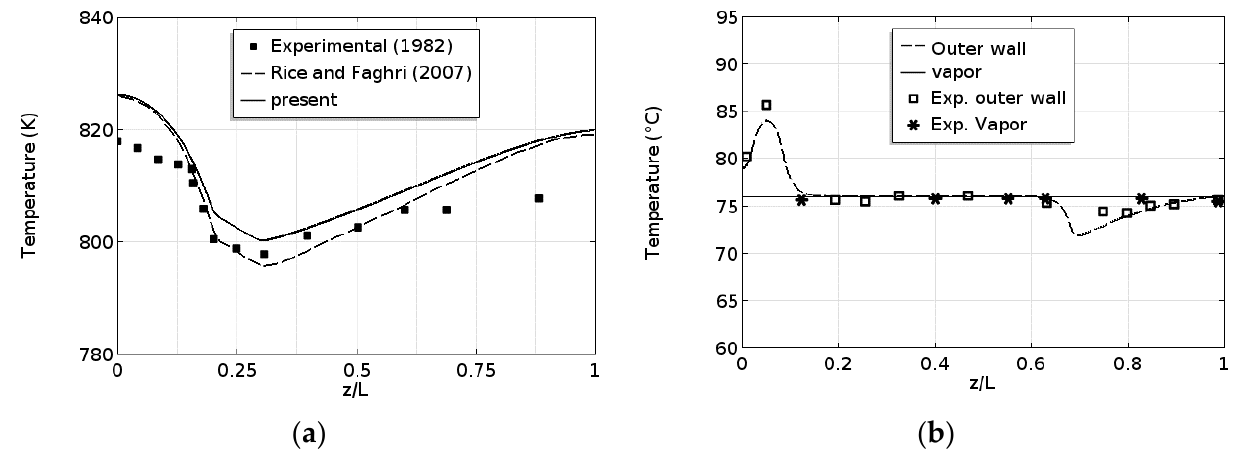
Figure 3. ( a ) The vapor temperature profile at the centerline of the HTHP cylinder. ( b ) The temperature at the outer wall and centerline vapor temperature in the LTHP experiment.